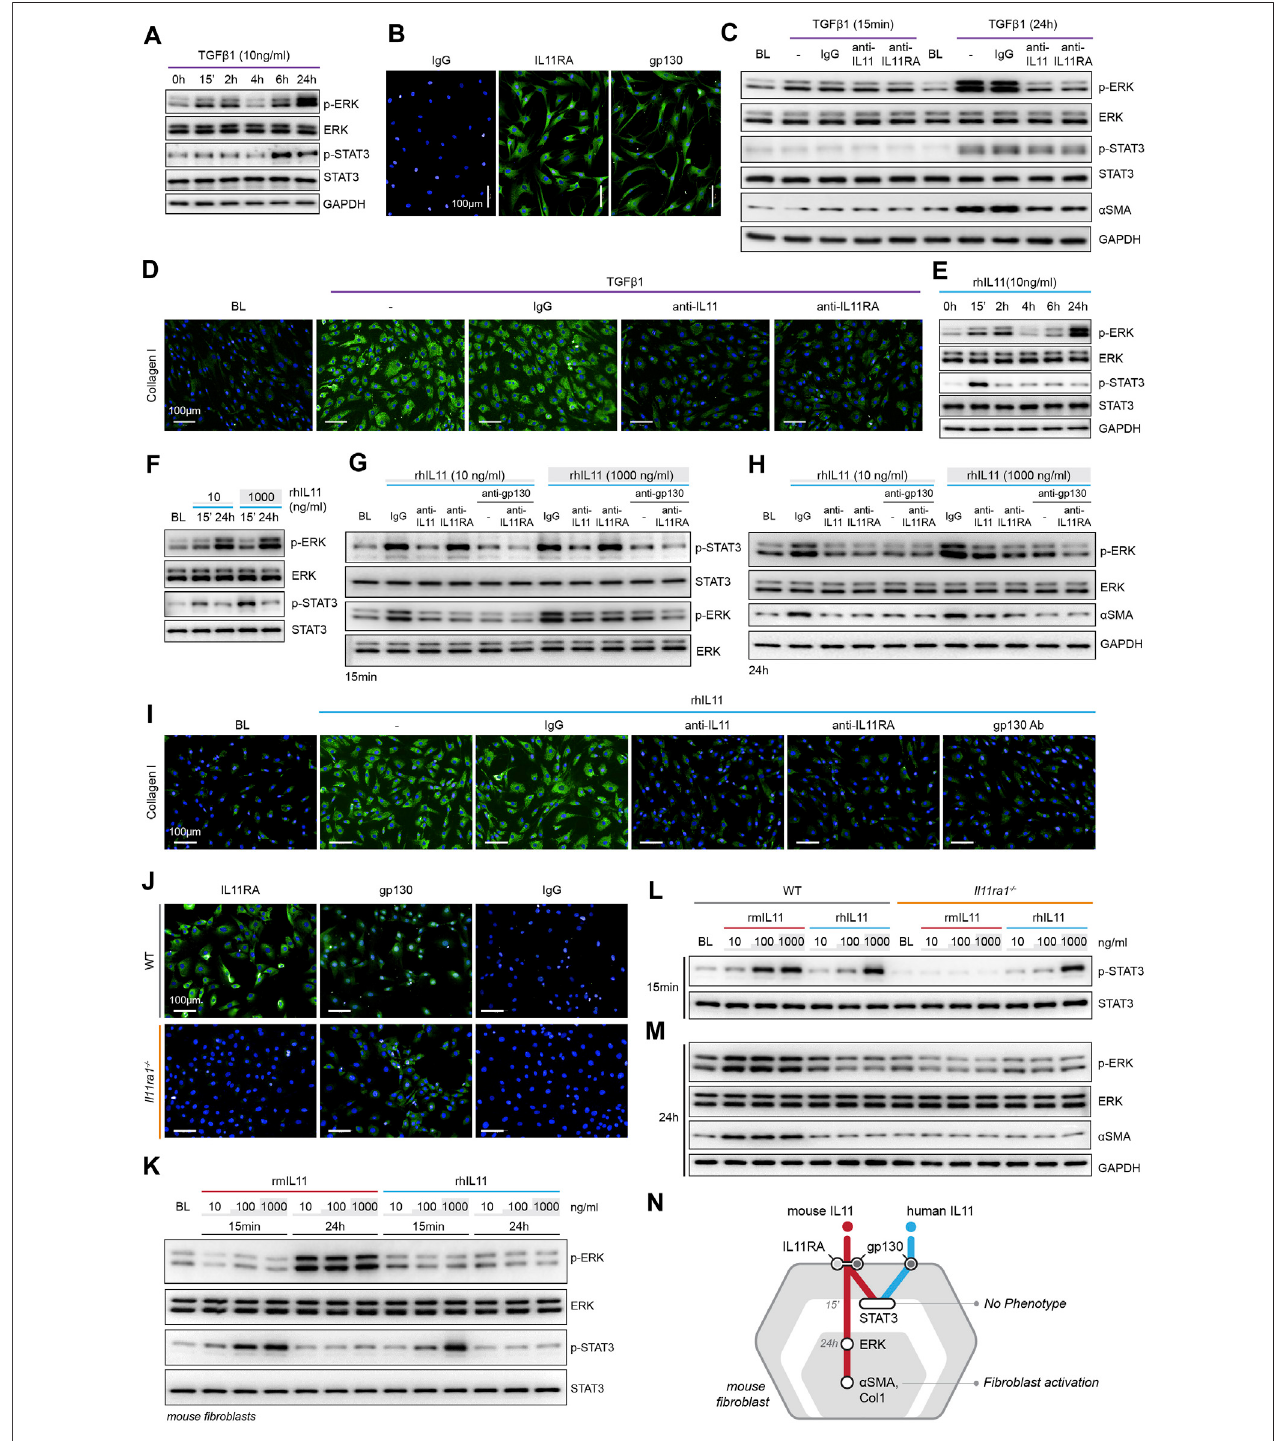
FIGURE 1 | TGF β 1-/IL11-driven fi brogenesis is coincident with activation of ERK, unrelated to STAT3 phosphorylation and shows species-speci fi c effects. (A) Western blots of ERK and STAT3 activation in TGF β 1-stimulated HCFs over a time course ( n (cid:2) 1). (B) Representative immuno fl uorescence (IF) images of IL11RA, and gp130expressioninHCFs(scalebars,100 μ m; n (cid:2) 3). (C,D)(C) Westernblotanalysisofp-ERK,ERK,p-STAT3,STAT3,and ⍺ SMA( n (cid:2) 1)and (D) IFimagesofCollagen I staining ( n (cid:2) 3) in TGF β 1-stimulated HCFs in the presence of either IgG, anti-IL11, or anti-IL11RA. (E) Western blots of ERK and STAT3 activation status in IL11-stimulated HCFs over a time course ( n (cid:2) 1). (F) Western blots showing ERK and STAT3 activation status in HCFs following stimulation with low and high dose IL11 ( n (cid:2) 1). (G – I) Effects of anti-IL11, anti-IL11RA, or anti-gp130 on inhibiting (G – H) ERK and STAT3 activation ( n (cid:2) 1) and (I) Collagen I Induction ( n (cid:2) 3) in